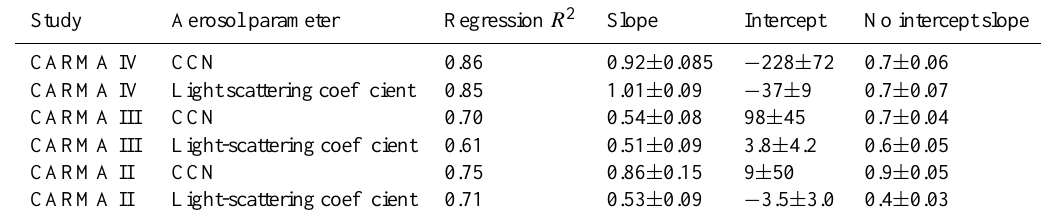
Table 2. Values of R 2 for linear regressions of measured aerosol properties onto those predicted by the PMF model. Study